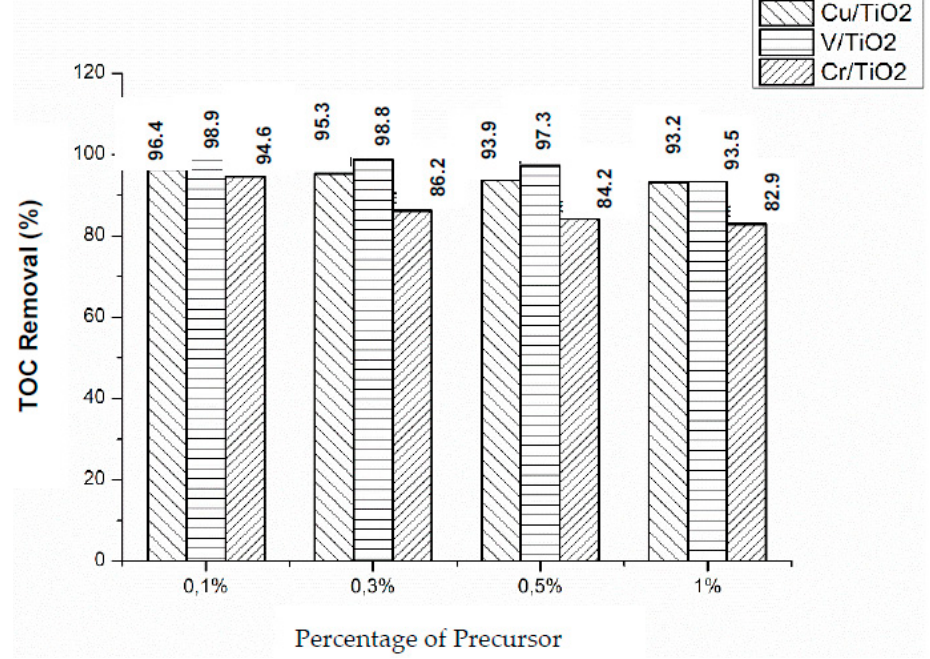
Figure 10. Total organic carbon (TOC) removal during the photocatalytic degradation of phenol over M(X%)/TiO 2 after 300 min of NUV-Vis light irradiation. [Phenol]0 = 50 mg·L –1 , [M(X%)/TiO 2 ]0 = 1.0 g·L –1 , natural pH, and T = 298.0 K.